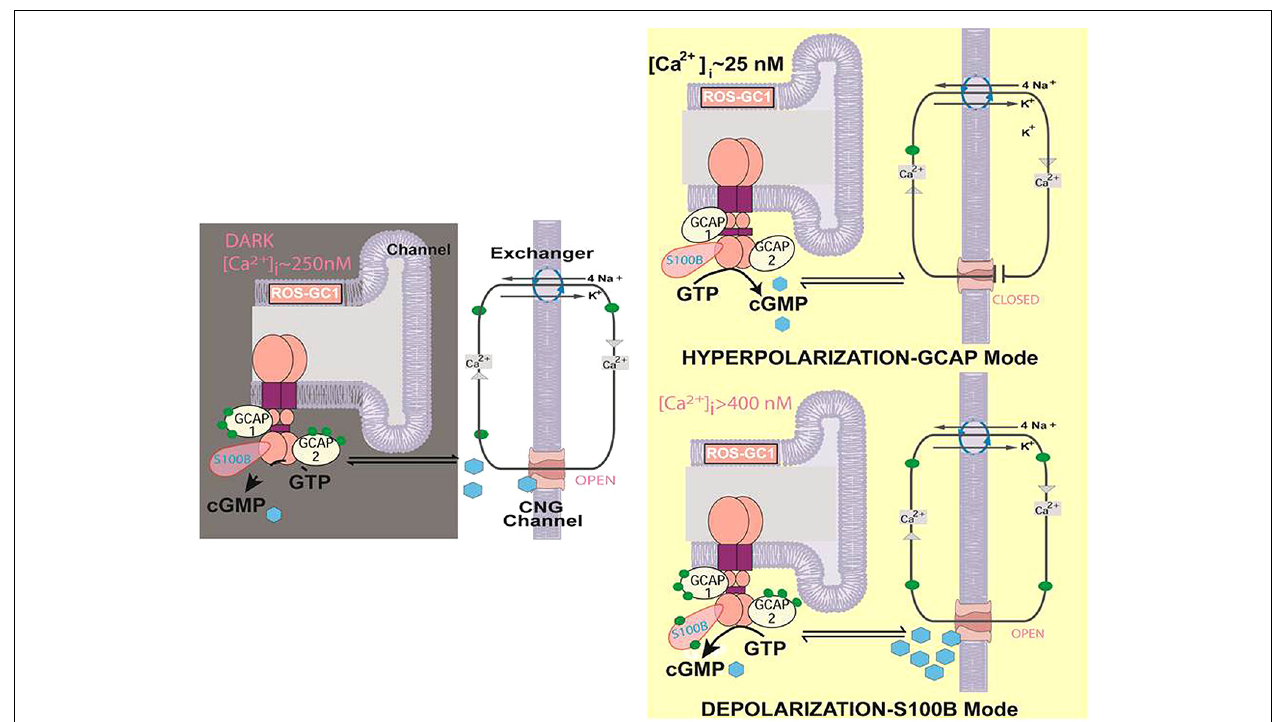
FIGURE 4 |Two modes of ROS-GC1 modulation by [Ca 2+ ] i in cones. Dark state [left] . At [Ca 2 + ] i ∼ 250 nM Ca 2 + sensors: GCAP1, GCAP2, S100B are ROS-GC1 bound; GCAP1 and GCAP2 are [Ca 2 + ] i bound; ROS-GC1 is in the basal state. Cyclic GMP generated keeps a fraction of CNG channels open allowing an influx of Na + and Ca 2 + . In this graphical simplification, GCAP2 and S100B are shown bound to the same ROS-GC dimer but it is more likely that these two Ca 2 + sensors bind separate dimers. Hyperpolarization-GCAP mode [Top right]. LIGHT triggers activation of phosphodiesterase and hydrolysis of cyclic GMP. The decrease in cyclic GMP causes CNG channels to close, preventing influx of Na + and Ca 2 +